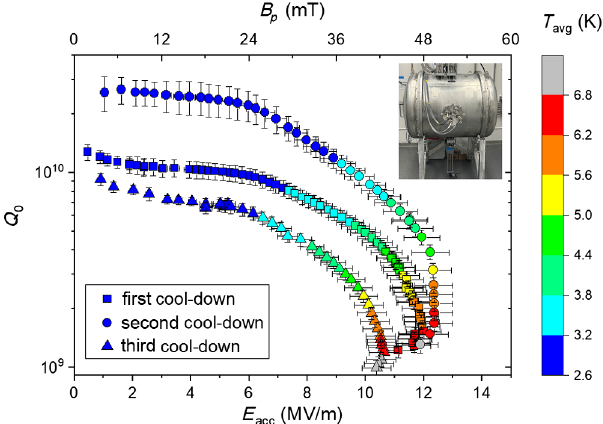
FIG. 23. Q 0 as a function of the rf field for the conduction- cooled prototype cavity measured at General Atomics for differ- ent cool-down conditions summarized in Table III. All the data points were measured in steady-state conditions and the symbols ’ colors correspond to the average equator ring temperature. The cavity performance was limited by thermal instability beyond the lowest measured Q 0 -value. The inset shows a photo of the HTC.